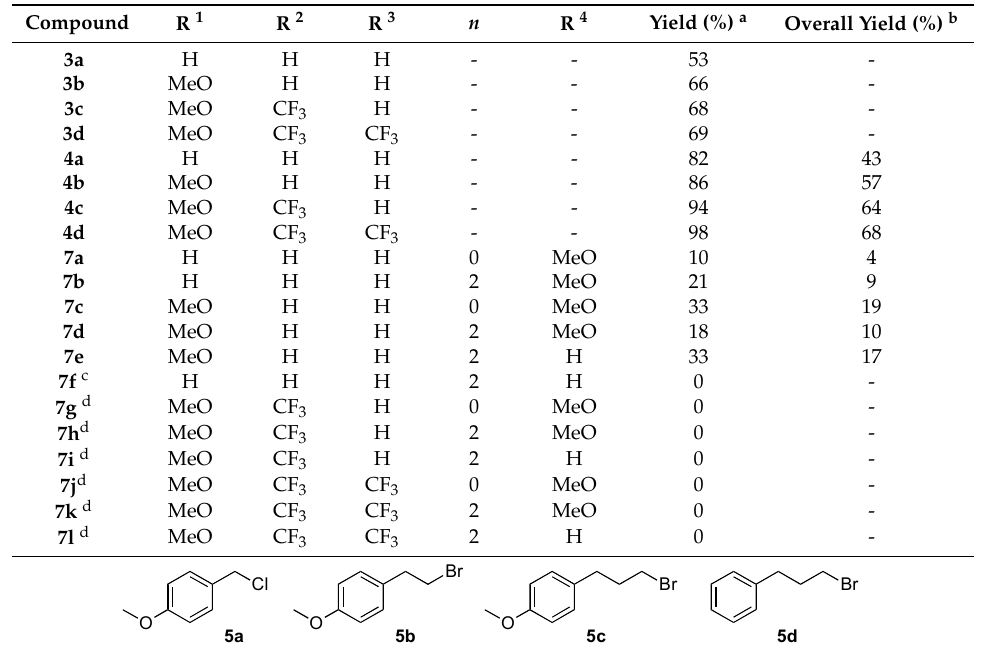
Table 1. Results for the preparation of 1-phenyl-2-(1 H -pyrazol-1-yl)ethan-1-one 3a – d